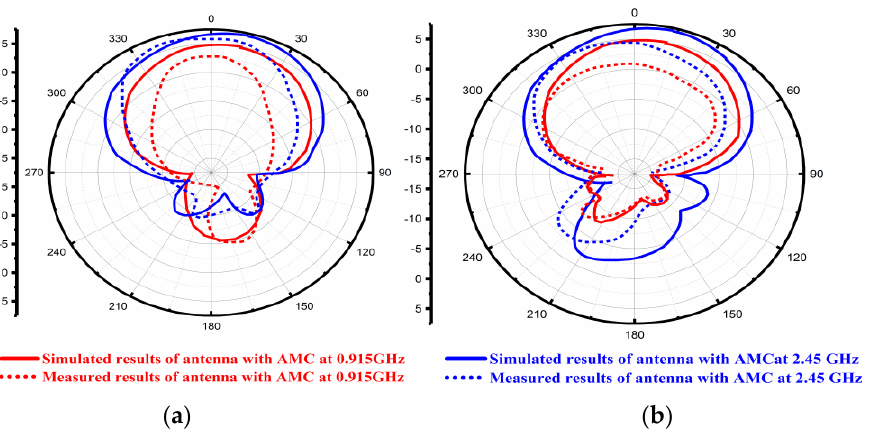
Figure 18. Simulated and fabricated Radiation Pattern of AMC backing Antenna ( a ) Along the E-Plane, ( b ) Along the H-Plane.